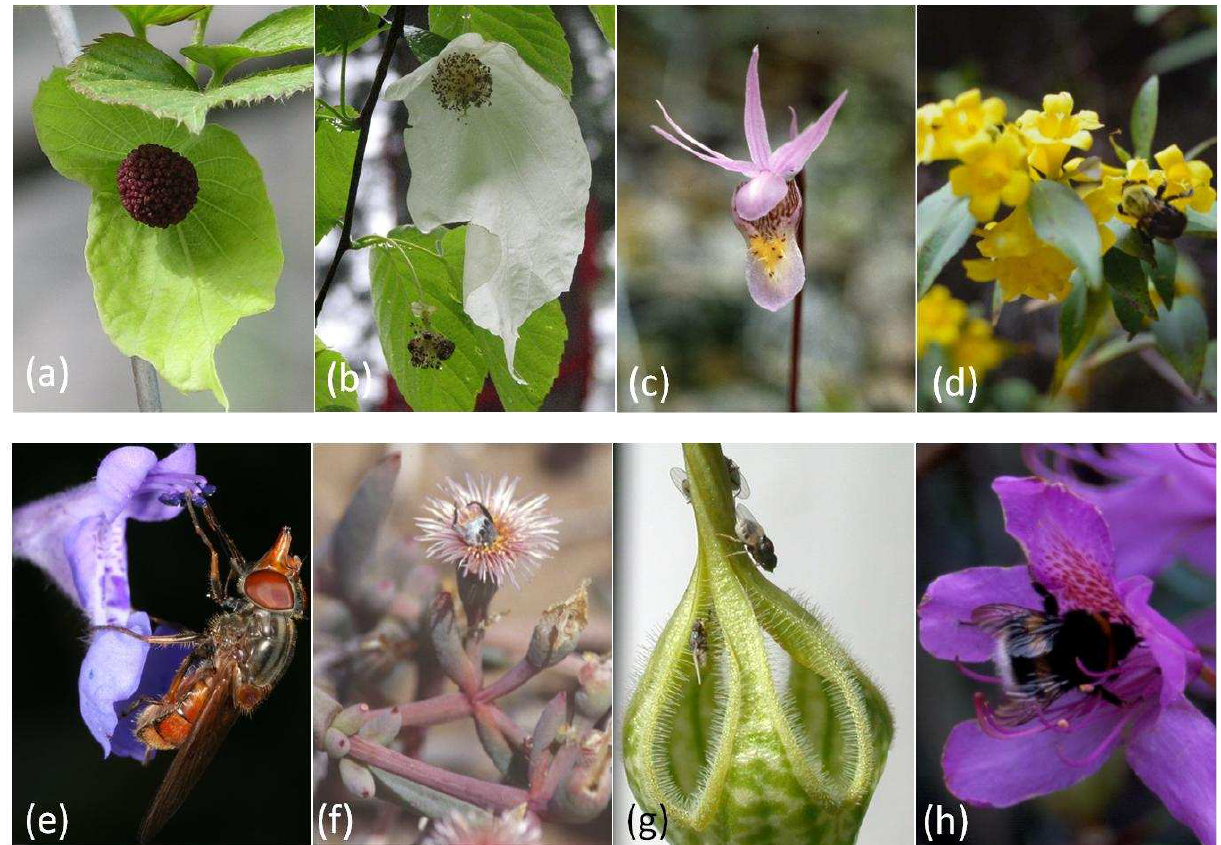
Figure 1. A few examples of the amazing breadth of pollination ecology: The dove tree ( Davidia involucrata ) has “naked” flowers that lack a perianth but are surrounded by two large bracts. These turn from green (a) to white (b) when flowers open which increases pollinator attraction (see Sun et al. 2008). Calypso bulbosa (c), a rewardless orchid, has evolved to deceive naïve bumblebees in the early spring to effect pollination without payment in nectar (see Ackerman 1981). The perennial vine, Gelsemium sempervirens (d), contains alkaloids in all plant parts including corollas and nectar which deter floral herbivores and nectar robbers but - in high concentrations - also pollinators (Adler & Irwin 2005). Hoverflies (e) visit flowers in a large range of habitats, they even pollinate cultivated plants. Though they are numerous, species-rich and wide-spread, their role as pollinators is often still neglected. (f) In the Succulent Karoo of South Africa, monkey beetles (Hopliini) are important pollinators of many plant species (Mayer et al. 2006). This one is diving into a flower of Ruschia goodiae (Aizoaceae) to reach nectar. (g) Flowers of Ceropegia arabica (Apocynaceae) are pollinated by small Diptera in common with all other members of the genus studied to date (Ollerton et al. 2009). Photograph by Sage Reynolds. Rhododendron ponticum (h) is a highly invasive plant in Ireland. Though it provides food resources for generalist bumblebees, effects on native plant pollinator interactions vary with intensity of